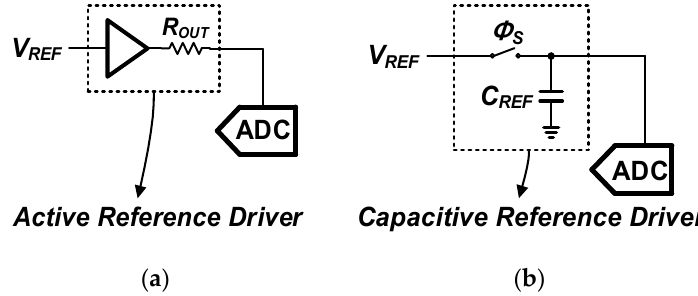
Figure 1. Two types of analog-to-digital converter (ADC) reference driver; ( a ) an active reference driver and ( b ) a capacitive reference driver (CRD).